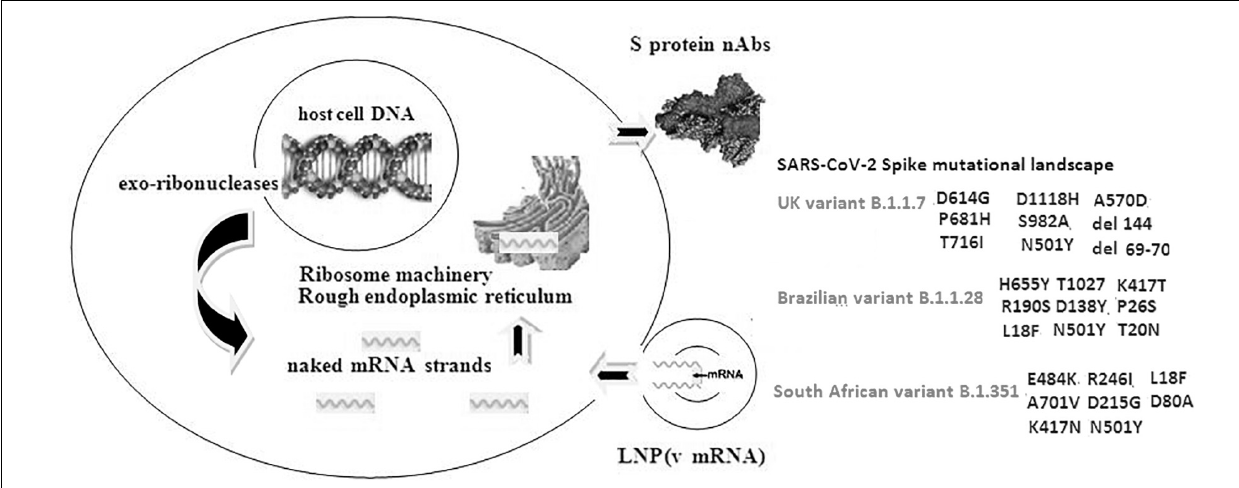
FIGURE 1 | Schematic presentation of a target cell—mRNA LNP based vaccine interaction and the SARS-CoV-2 Spike glycoprotein major mutational landscape. Nucleoside-modified viral messenger RNA (v mRNA) genomic sequence is encapsulated within nanoparticles—specifically lipid ones (LNPs). Insertion of the LNP-m RNA complex is followed by translation of the corresponding transcript in the ribosome machinery and final synthesis of the S protein S protein neutralizing antibodies (nAbs) in rough endoplasmic reticulum which are exported from the cell membrane in order to sensitize T cells and motivate a specific anti SARS-CoV-2 immune response. Mutations (specific RNA substitutions and deletions) affecting the spike glycoprotein create the corresponding virus RNA variants and are responsible for different rates of anti-SARS-CoV-2 resistance reducing immune response in the first generation v-mRNA vaccines.